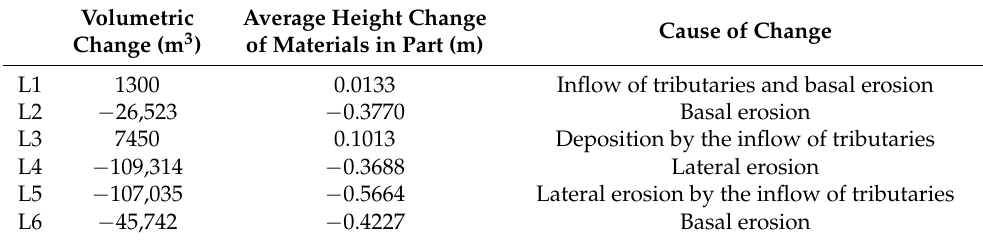
Table 2. Characteristics of channel changes in the different parts of the channel.